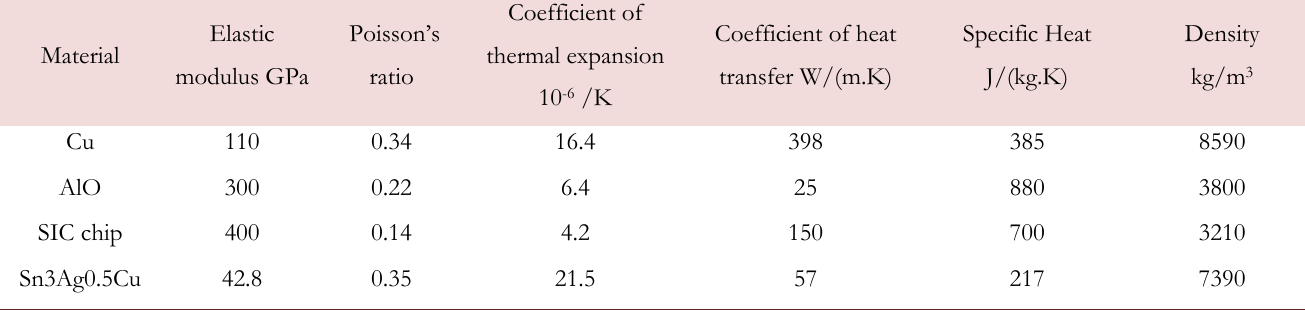
Table 1: The mechanical property of the SiC-IGBT power